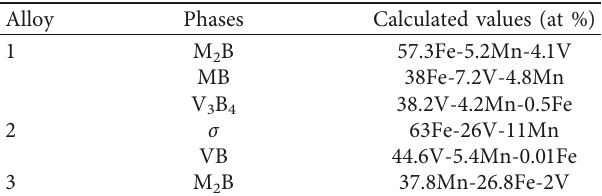
Figure 7: (a) Microstructure of the alloy 2 after annealing and (b) detail and (c) distribution of vanadium in the corresponding alloy. Table 5: Chemical composition of equilibrium phases at